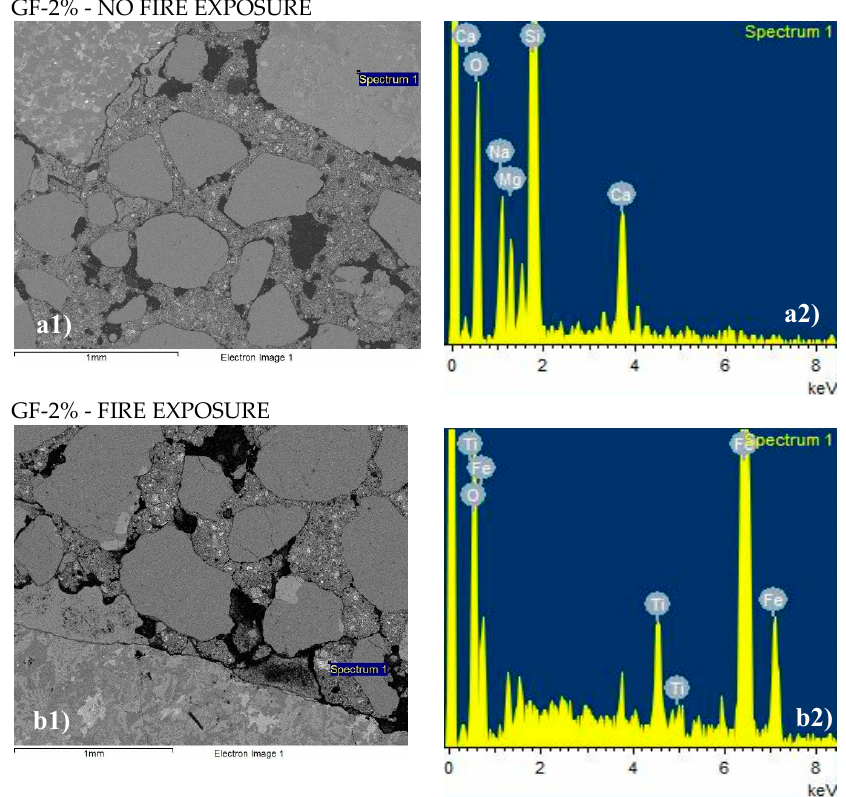
Figure 11. Energy dispersive x-ray microanalysis at 100 magnifications of thin-layer test pieces containing 2% of CNFs. ( a ) Before thermal aggression; ( b ) After thermal aggression.